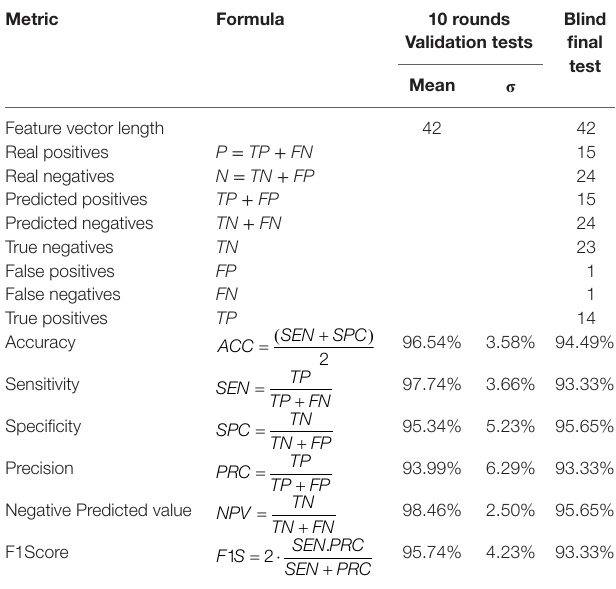
TaBle 3 | Zika virus (ZIKV) diagnosis classifier’s tests